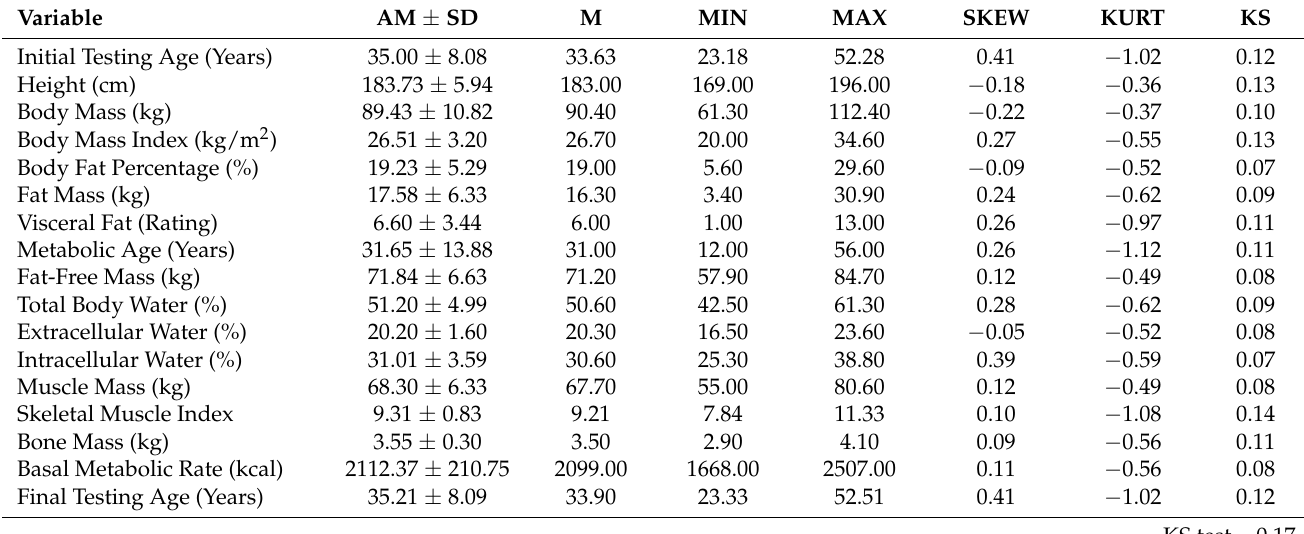
Table 2. Descriptive parameters and sensitivity of the experimental group (N = 63).